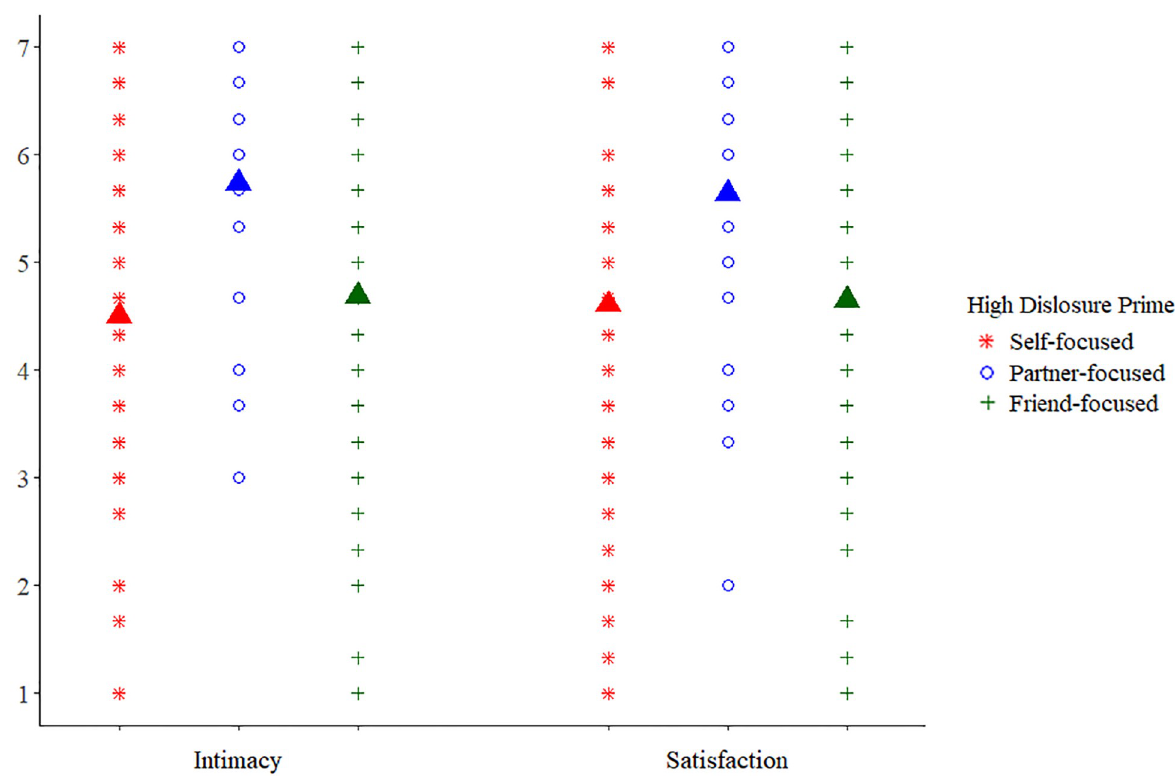
Fig 4. Study 5 means for intimacy and satisfaction in each of the prime